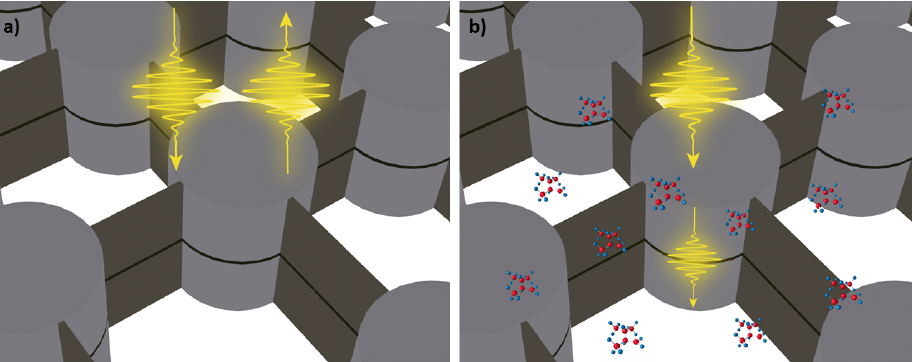
Figure 1. Intensity-based sensing mechanism and the metasurface composed of two arrays of cylinders held together by thin spokes. When the analytes are not present, all the impinging light is reflected ( a ). If the refractive index of the surrounding medium is modified by the presence of gases, the light transmission increases according to the concentration ( b